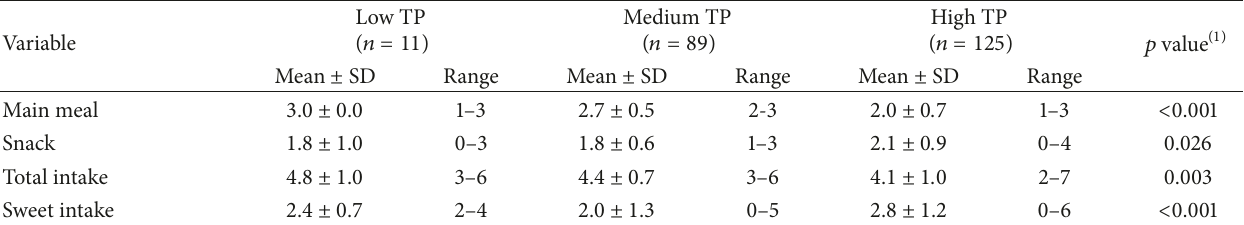
Table 3: Mean and standard deviation (SD) for main meal, snack, total intake, and sweet intake in Saudi schoolchildren according to TP (taste preference ) groups (low, medium, and high).